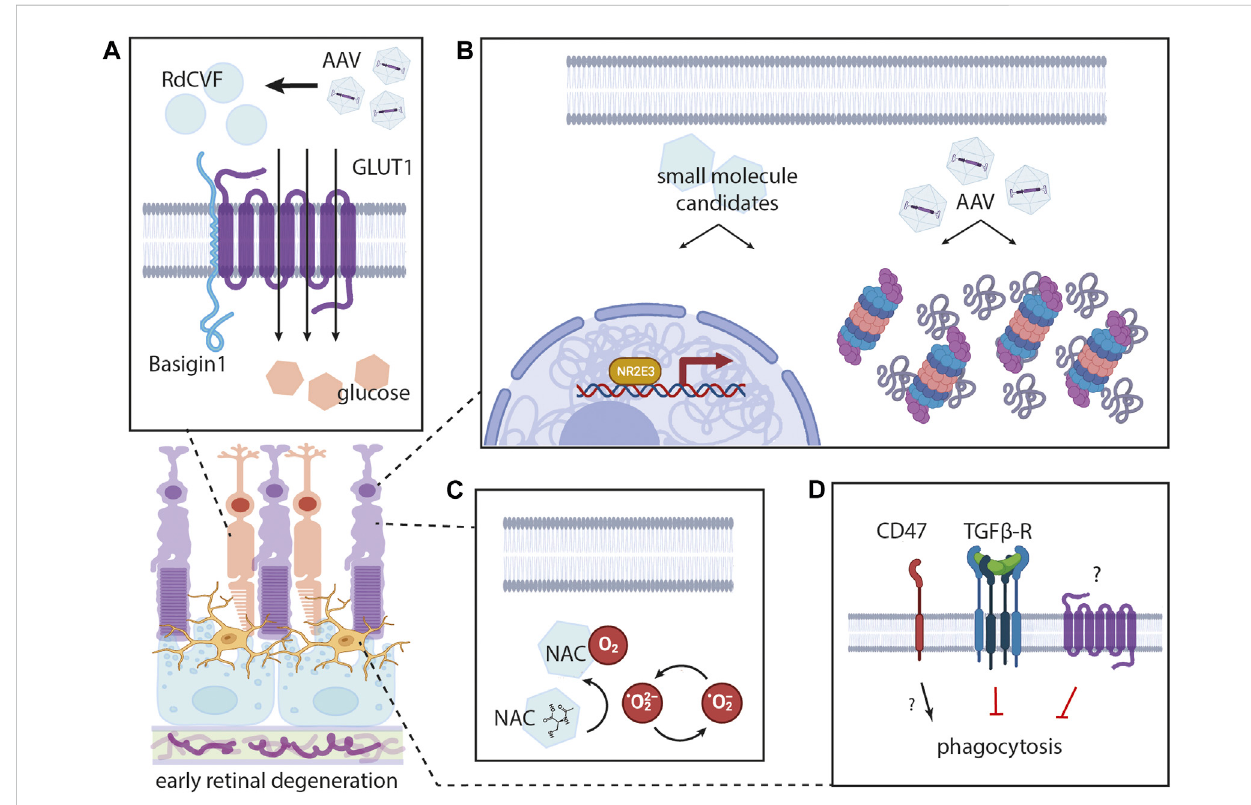
FIGURE 2 Mechanismsfor enhancing photoreceptor survival in early retinal degeneration. Introducing Rod-derivedCone Viability Factor (RdCVF) (A) through use of AAVs represents one potential strategy for promoting cone photoreceptor survival. The working model for this mechanism includes activation of the Basigin-1/GLUT1 complex to increase transport of glucose and potentially other similar metabolites. Proteasomal enhancement ( (B) , right ) to clear excess misfolded proteins represents another possible approach. This strategy could be harnessed through the discovery of small molecules or through gene augmentation for proteasomal machinery. These approaches could also be used for augmenting certain nuclear hormone receptors (like NR2E3) ( (B) , left ). Oral supplementation with antioxidants like N-Acetylcysteine (NAC) (C) may also support photoreceptor health, with NAC as a known scavengerofreactiveoxygenspecies.Alternativestrategiesincludelimitingactivationofmicroglia (D) ,byinhibitingexcessivephagocytosis( i.e., inhibiting the TGF β receptor), while harnessing their role in maintenance of the